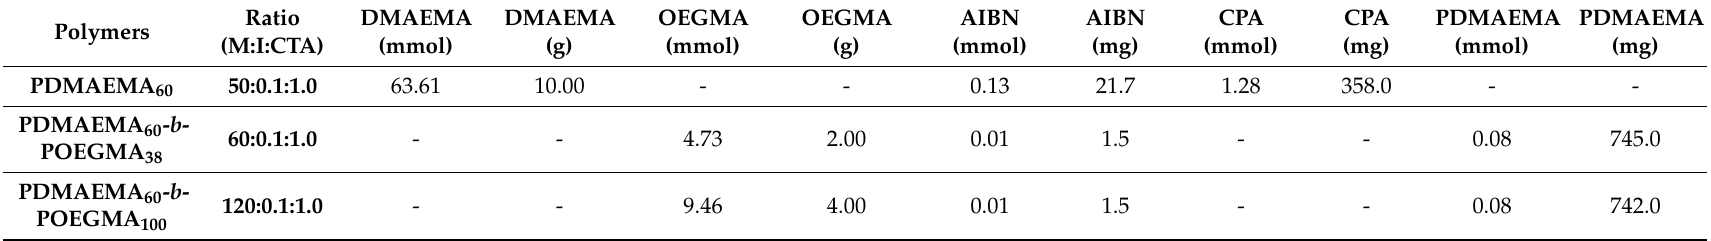
Figure 1. Quaternization of the DMAEMA repeating units of the homopolymer or PDMAEMA n - b -POEGMA m block copolymers via reaction with excess iodomethane in acetone. Table 1. Amounts of DMAEMA, PDMAEMA, OEGMA, AIBN initiator and CPA chain transfer agent used in the synthesis of PDMAEMA and PDMAEMA n - b -POEGMA m .